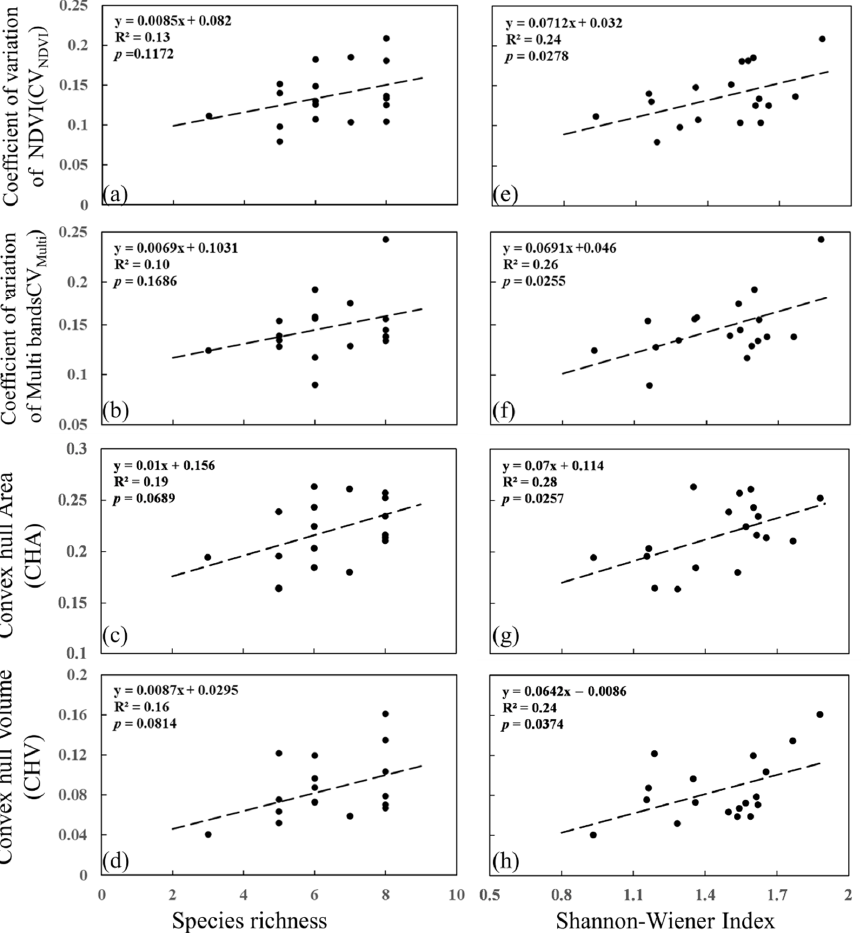
Figure 2. The relationships between species diversity and spectral diversity with soil information. The left column indicates the relationships between four spectral diversity metrics and species richness ( a – d ) and the right column indicates the relationships between four spectral diversity metrics and Shannon–Wiener index ( e – h ). Table 2. The correlations between species diversity indices and spectral diversity metrics